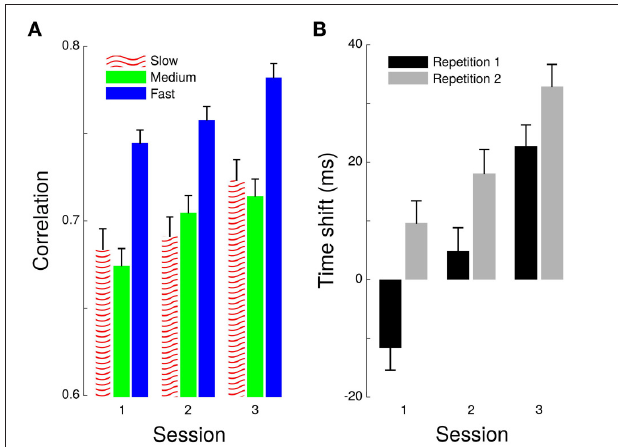
FIGURE 3 | Cross-correlation between grip and load forces. Largest coefficient of correlation between grip and load forces (A) and the time shift for which this condition was fulfilled (B) . Correlations are shown across Sessions (x-axis) and separately for each Frequency (see legend). Time-shifts are also depicted across Sessions (x-axis) but separately for Repetition 1 (black bar) and Repetition 2 (gray bar) of frequency.